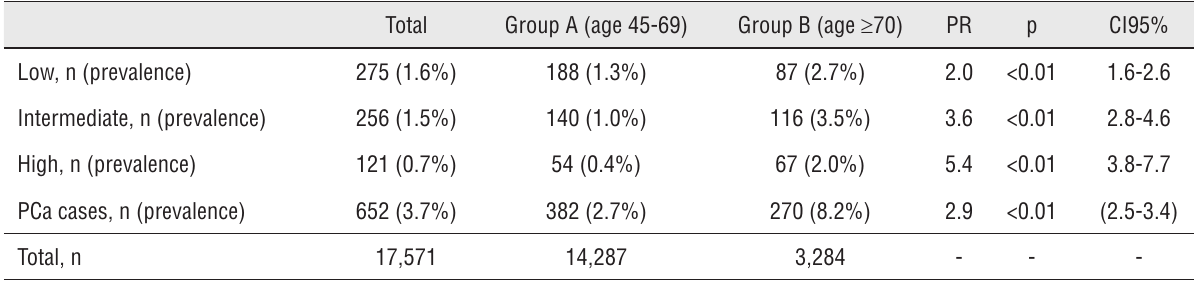
Table 4 - D’Amico risk stratification comparison of prevalence by